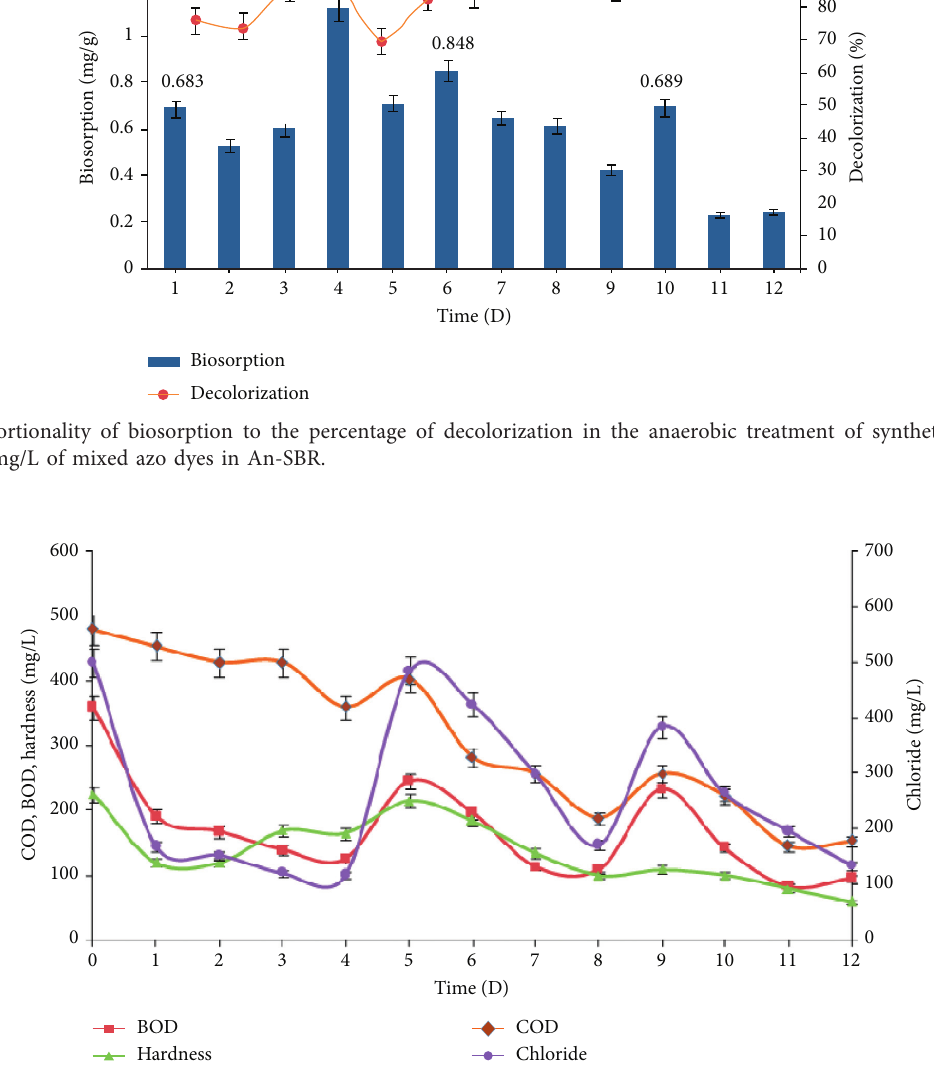
Figure 3: Removal of COD, BOD, chloride, and hardness in the anaerobic treatment of synthetic textile effluent containing 100mg/L of mixed azo dyes in